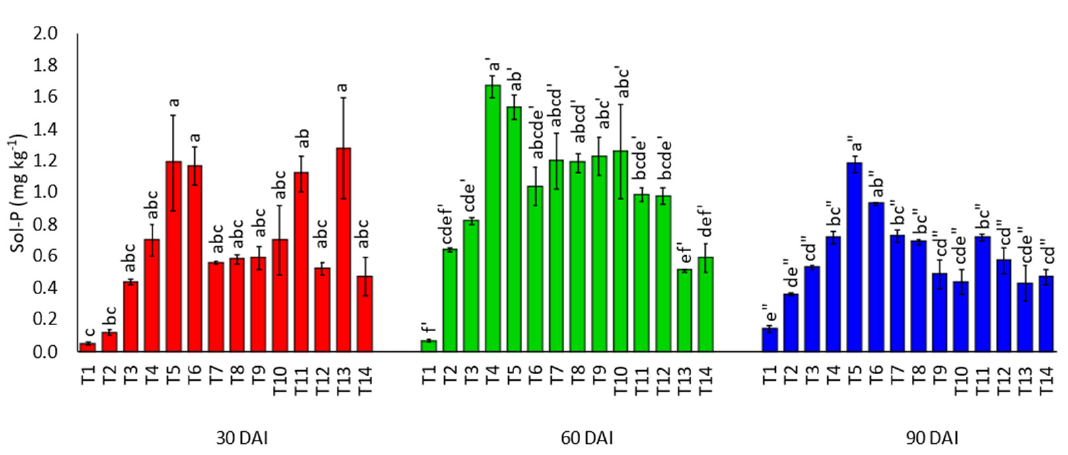
Figure 16. Effects of treatments on loosely soluble phosphorus after thirty, sixty, and ninety days of incubation, where T1: soil alone, T2: Egypt rock phosphate alone, T3: Egypt rock phosphate + 100% charcoal, T4: Egypt rock phosphate + 100% sago bark ash, and T5: Egypt rock phosphate + 100% charcoal + 100% sago bark ash, T6: Egypt rock phosphate + 75% charcoal + 75% sago bark ash, T7: Egypt rock phosphate + 50% charcoal + 75% sago bark ash, T8: Egypt rock phosphate + 25% charcoal + 75% sago bark ash, T9: Egypt rock phosphate + 75% charcoal + 50% sago bark ash, T10: Egypt rock phosphate + 50% charcoal + 50% sago bark ash, T11: Egypt rock phosphate + 25% charcoal + 50% sago bark ash, T12: Egypt rock phosphate + 75% charcoal + 25% sago bark ash, T13: Egypt rock phosphate + 50% charcoal + 25% sago bark ash, and T14: Egypt rock phosphate + 25% charcoal + 25% sago bark ash. Means with different letter(s) within the same incubation period indicate significant differences between treatments according to Tukey’s HSD test at p ≤ 0.05, i.e., a > b > c. Bars represent the mean values ± SE.